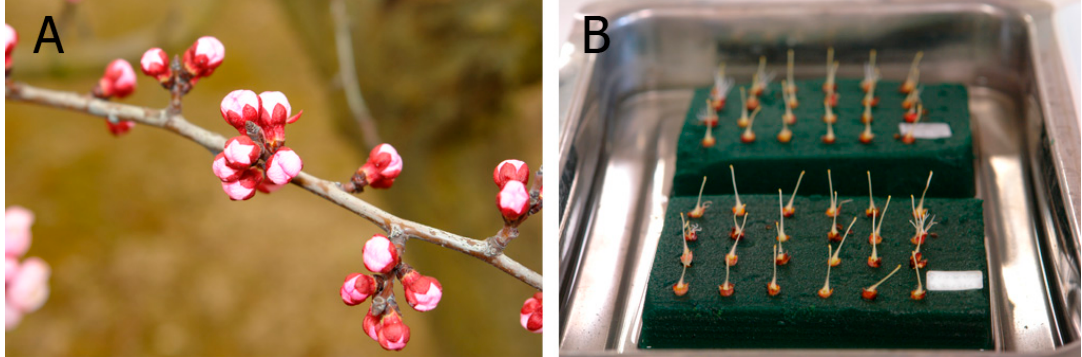
Figure 4. Apricot flowers at balloon stage in the field ( A ) and pistils on florist foam in water in the laboratory ( B ).